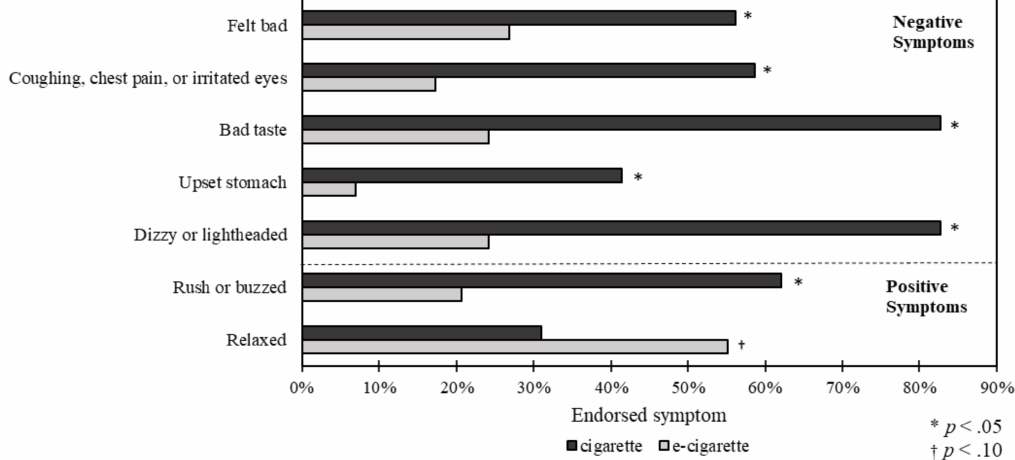
Figure 1. Symptoms during first use of cigarette vs. e-cigarette ( n = 41).